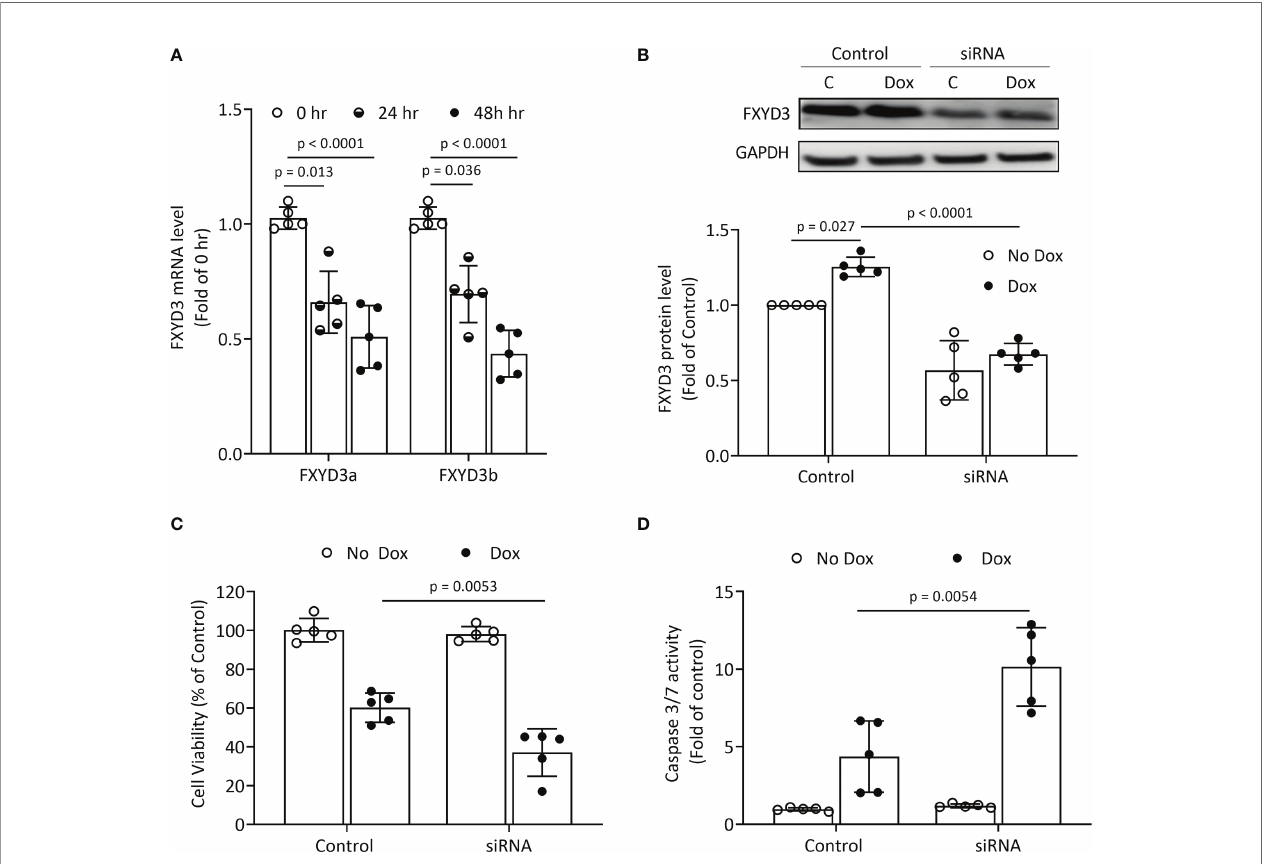
FIGURE 1 | FXYD3-siRNA transfection of BxPC-3 cells. (A) Expression of FXYD3a and FXYD3b mRNA after exposure of cells to FXYD3 siRNA for 24 or 48 h (B) Effect of siRNA and Dox on FXYD3 expression. Cells were exposed to 1 m M Dox or Dox-free culture medium for 48 h after transfection as indicated. (C) FXYD3 siRNA transfection and effect of Dox on cell viability. Cells were exposed to Dox or Dox-free culture medium as for (C) . (D) FXYD3 siRNA transfection and effect of Dox on Caspase-3/7